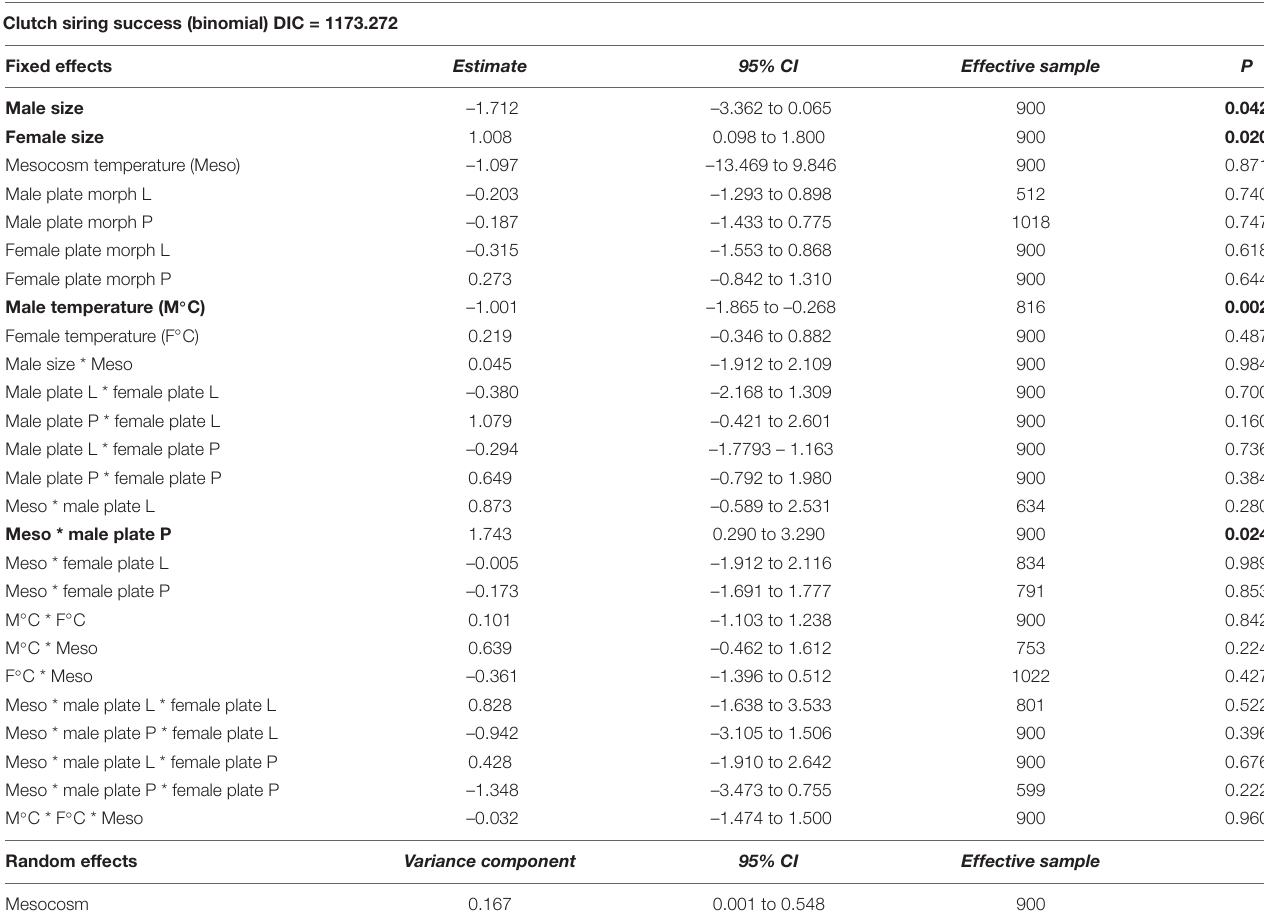
TABLE 1 | Clutch siring success of stickleback ( Gasterosteus aculeatus ) depending on environmental (mesocosm) temperature, lateral plate morph (C, complete; L, low; P, partial), and acclimation temperature ( ◦ C) of males and females. Clutch siring success (binomial) DIC =